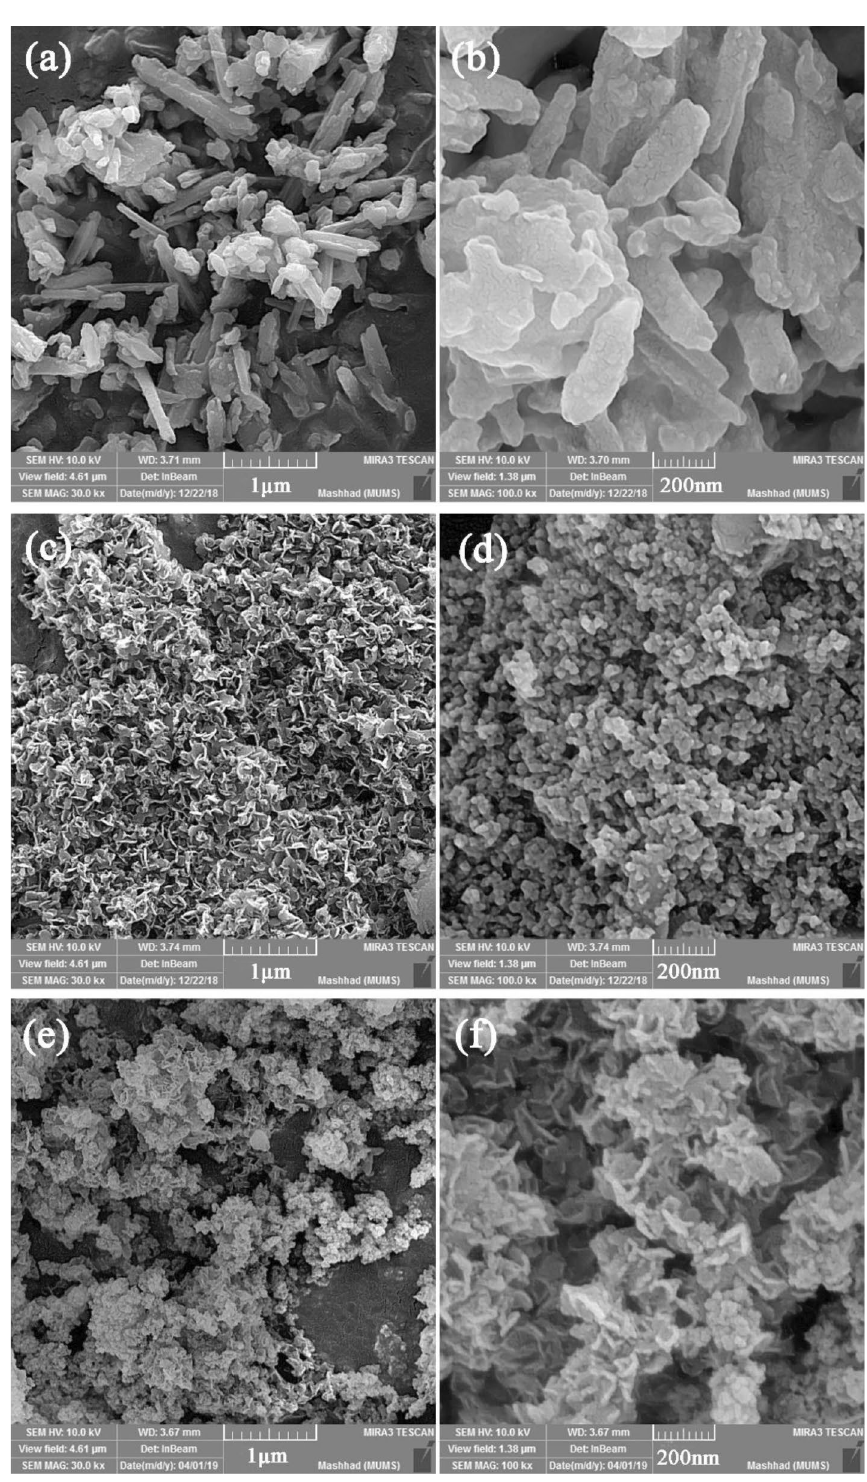
Figure 4. FE-SEM micrographs of ( a , b ) S, N-GQDs/HNTs, ( c , d ) CoFe 2 O 4 /HNTs and ( e , f ) CoFe 2 O 4 /S, N-GQDs/HNTs